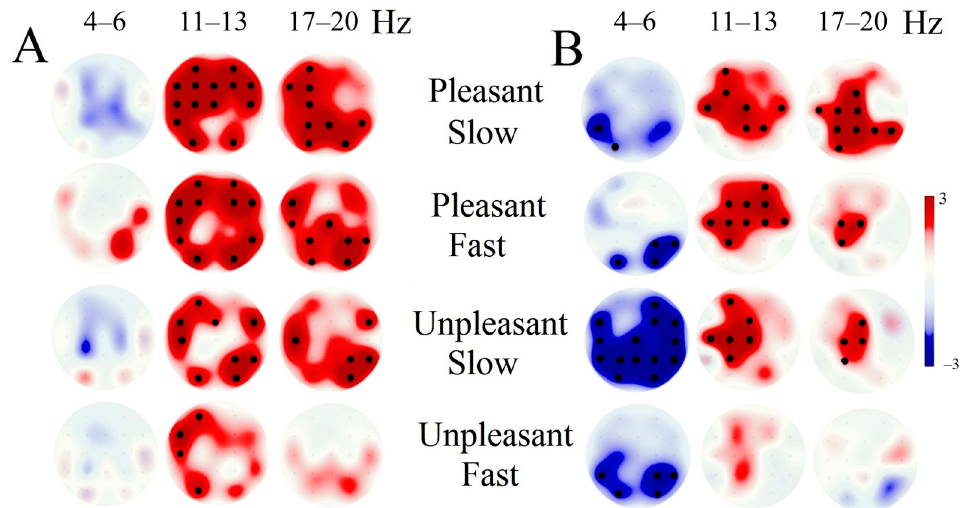
Figure 2. The di ff erence in theta rhythm (4–6 Hz), alpha rhythm 11–13 Hz, and beta rhythm power Figure 2. The difference in theta rhythm (4 – 6 Hz), alpha rhythm 11 – 13 Hz, and beta spectral density (PSD) between tactile stimulation and the resting states for both groups of subjects. rhythm power spectral density (PSD) between tactile stimulation and the resting states for A : control group, B : patients in coma. The bold black dots indicate a significant di ff erence after both groups of subjects. A : control group, B : patients in coma. The bold black dots Bonferroni indicate a significant difference after Bonferroni correction.